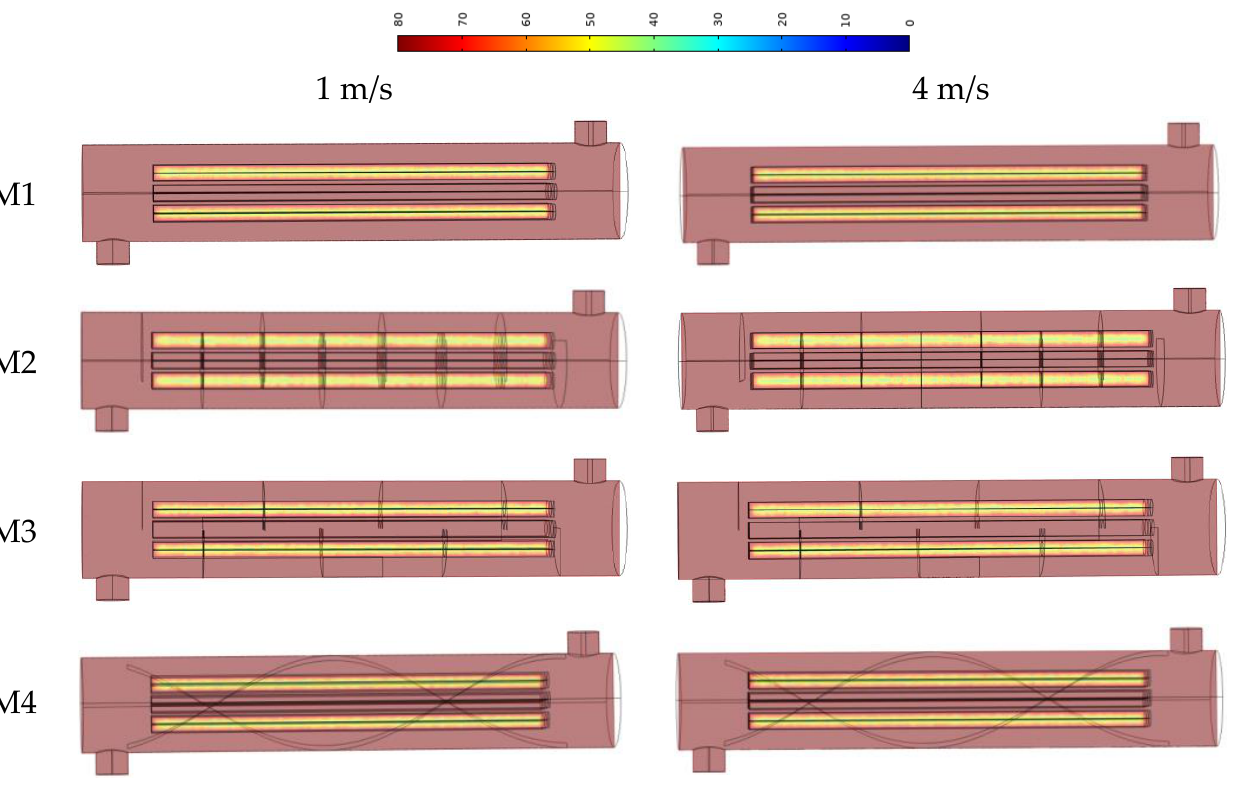
Figure 11. Temperature distribution for Models 1–4 at the time where Model 1 reaches the phase transition temperature (57 °C).